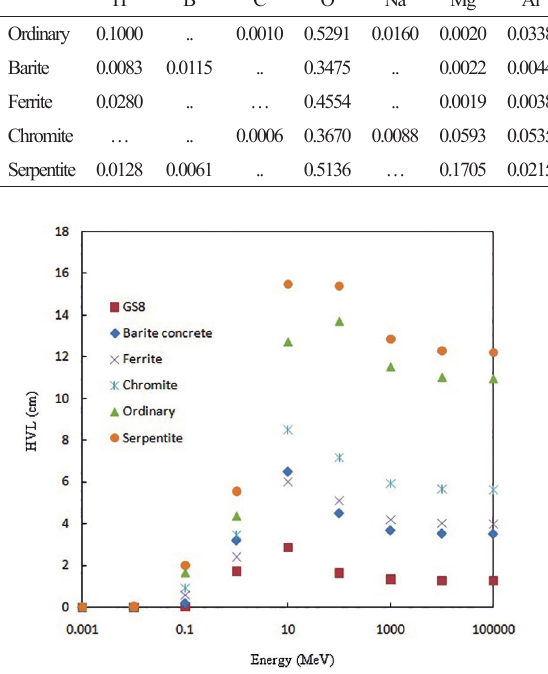
Table 4: Chemical composition of concretes. Concretes